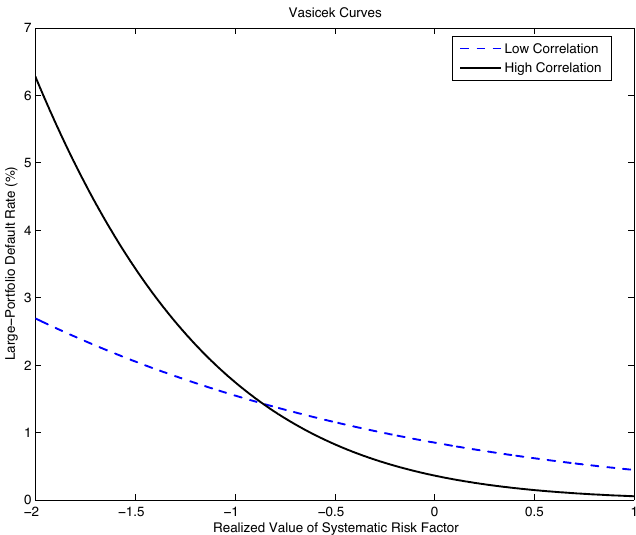
Figure 2.1: This figure illustrates two Vasicek default curves corresponding to different correlation levels. In both cases the default probability is 1%. For the solid line correlation is 25%, for the dashed curve correlation is 5%. Horizontal axis is the real- ized value of the systematic risk factor ( m ), vertical axis is the large-portfolio default rate in percentage points ( 100 · v x , a ( m ) ).